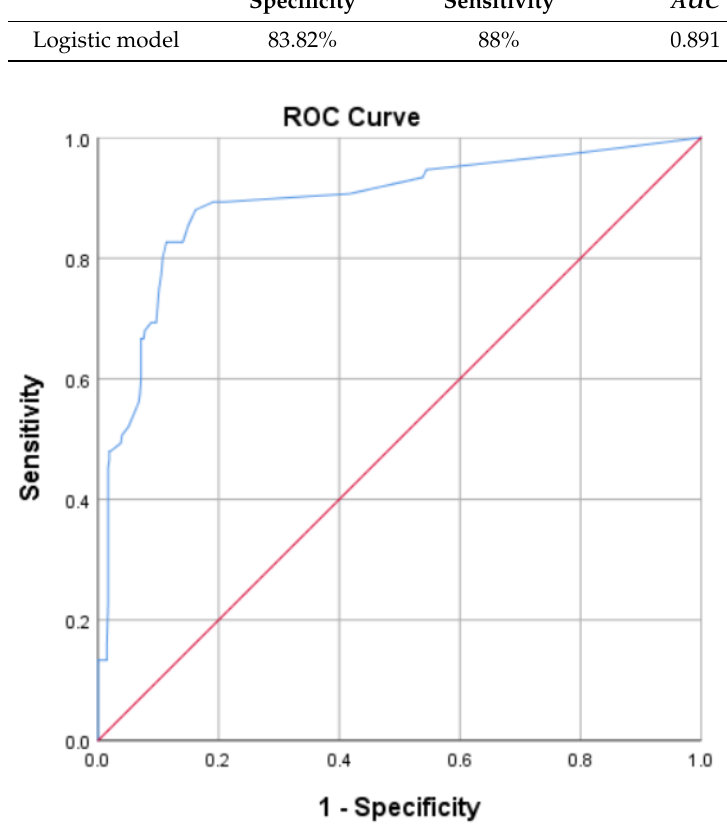
Table 6. Prediction accuracy of the logistic model.